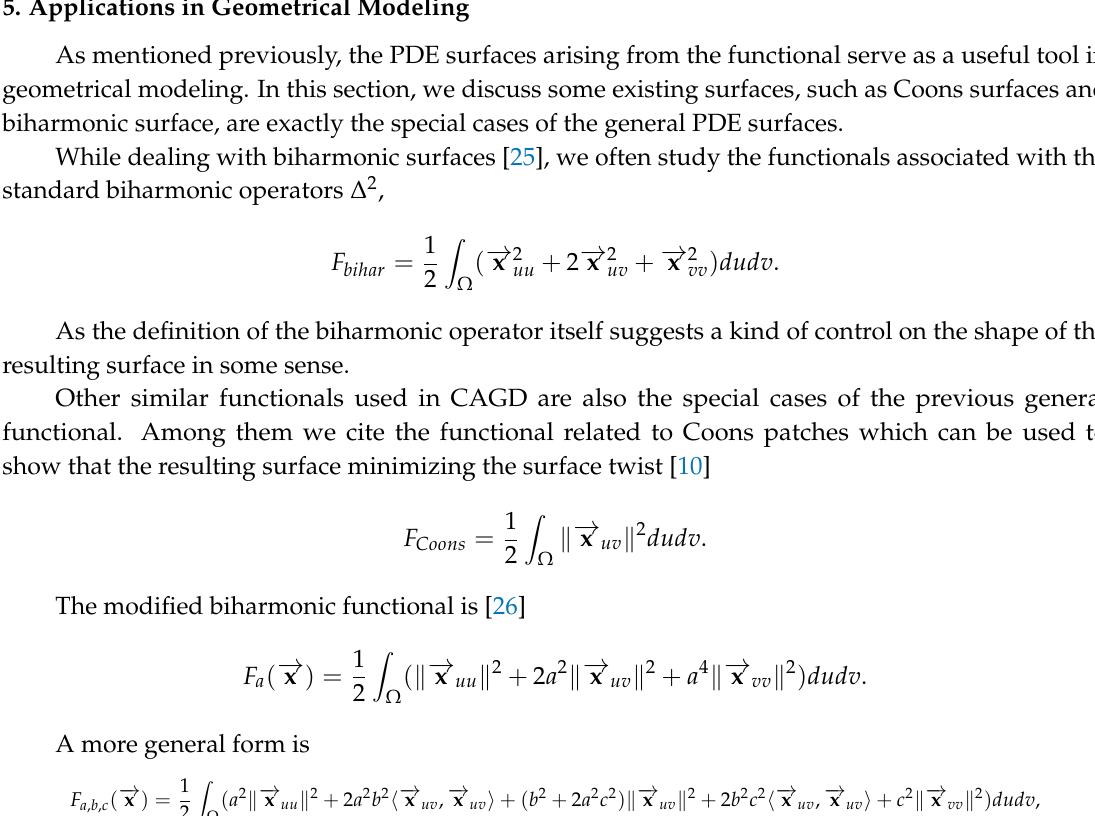
Figure 2. B-spline solutions of the fourth-order